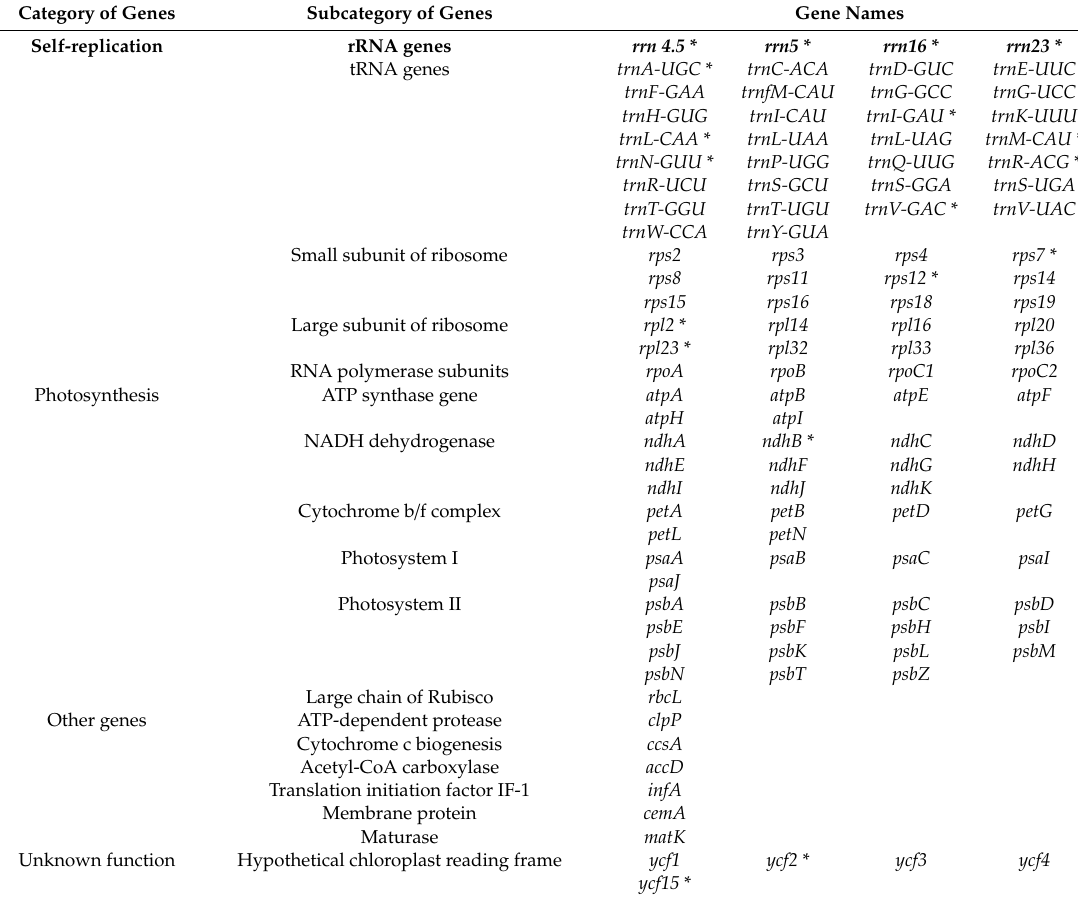
Table 2. List of the annotated genes in the Michelia shiluensis chloroplast genome. Category of Genes